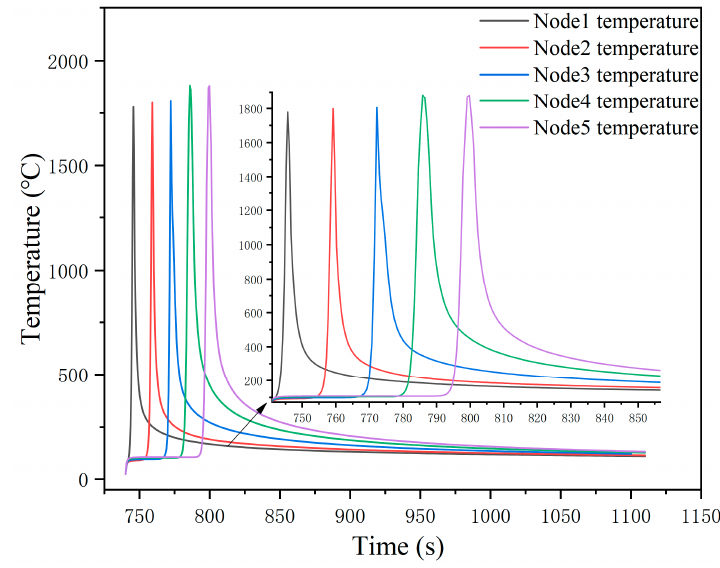
Figure 15. Initial welding temperature history.